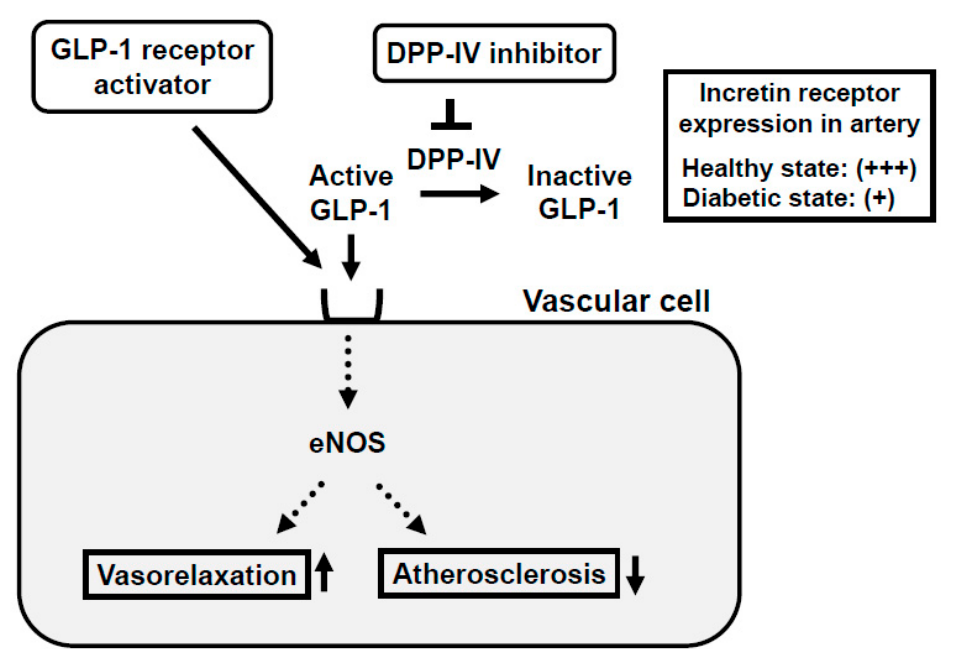
Figure 4. Mechanism of action of incretin and incretin-based agents in vascular cells and reduced expression of incretin receptor in arteries in a diabetic state. Binding of incretin to the incretin receptor in vascular cell membrane facilitates nitric oxide production, which leads to the enhancement of vasodilatory capacity and reduction of atherosclerosis. In a healthy state, the incretin receptor is abundantly expressed in the vascular cell membrane, but in a diabetic state, incretin receptor expression is substantially reduced.